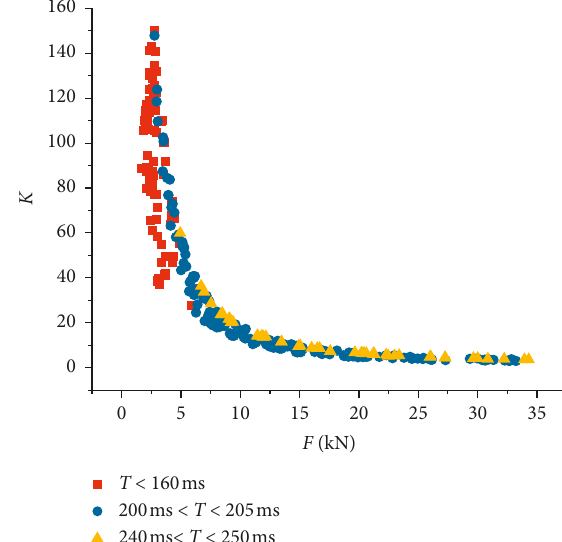
Figure 10: Layer of Pareto-optimal solutions for response time.